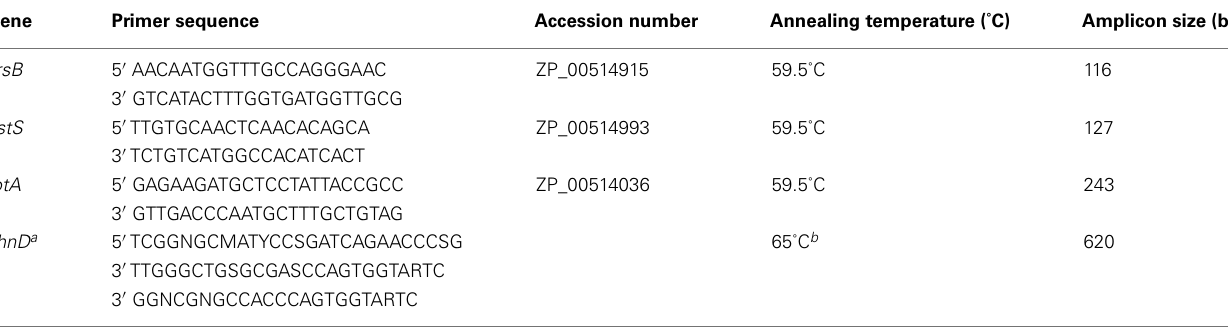
Table 1 | Primers and amplification conditions for the genes used in qRT-PCR and RT-PCR.